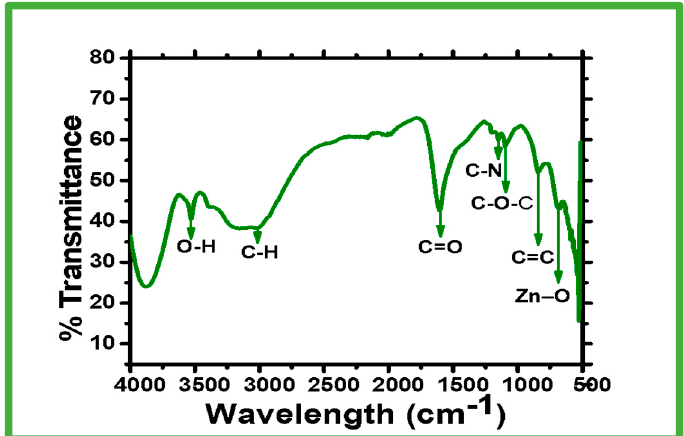
Figure 2. FTIR spectra of green-synthesized ZnONPs.